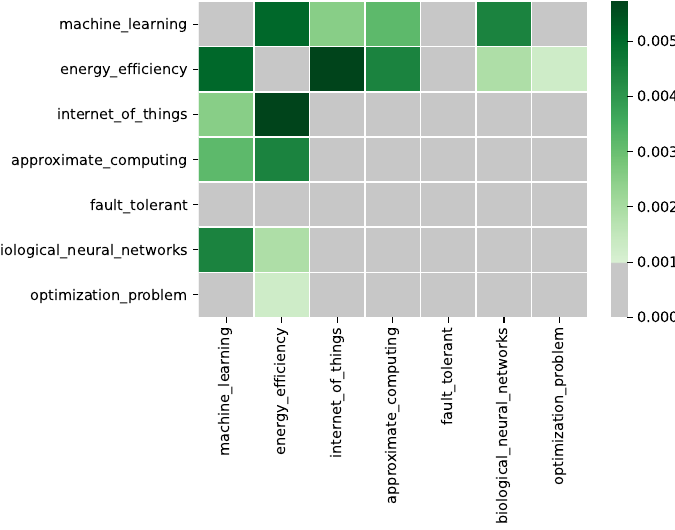
Figure 5. Visualization of feasible research gaps using heatmap.